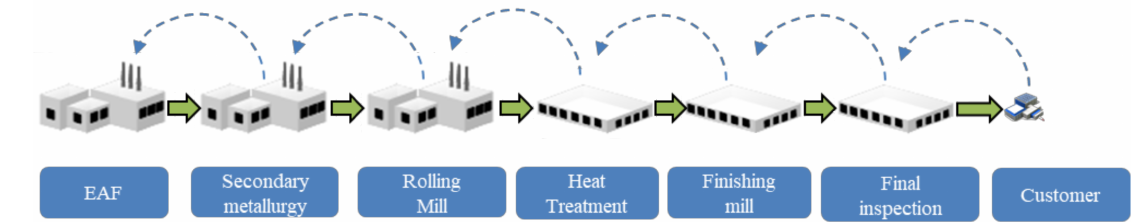
Figure 3. Manufacturing system of the metallurgical case study (own elaboration).